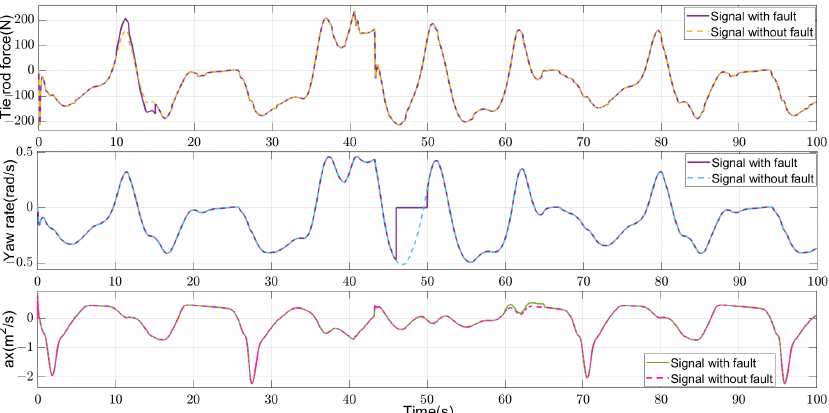
Figure 13. Sensor signal of tie rod force sensor, yaw rate sensor, and longitudinal acceleration (Solid line: Sensor signal with faults; dotted line: sensor signal without fault).